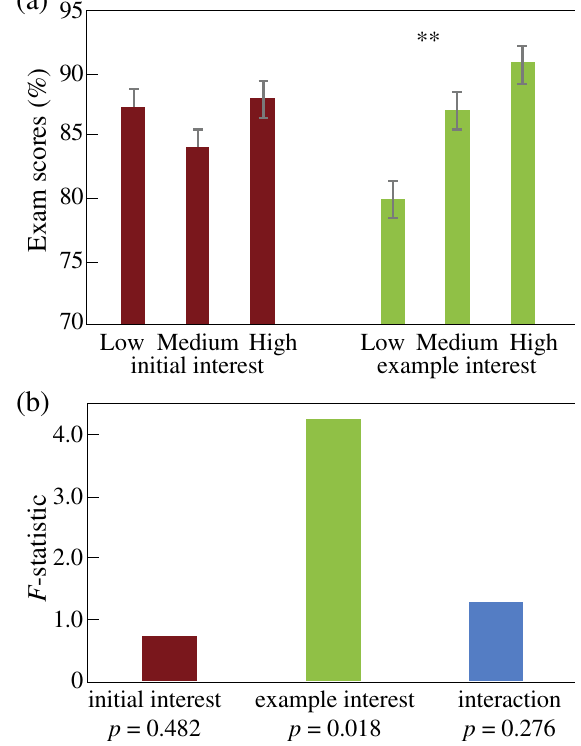
FIG. 3. (a) Average composite exam scores for initial interest groups (Personal Application Factor) and example interest groups. (** indicates that low, medium, and high example interest groups differ with statistical significance, p < 0 . 01 ) (b) F statistic for ANOVA conducted on composite examination scores, testing the contributions of initial interest in physics and example interest (low, medium, or high; measured as described in Secs. IV. D. 2 and IV. E) to the variance in